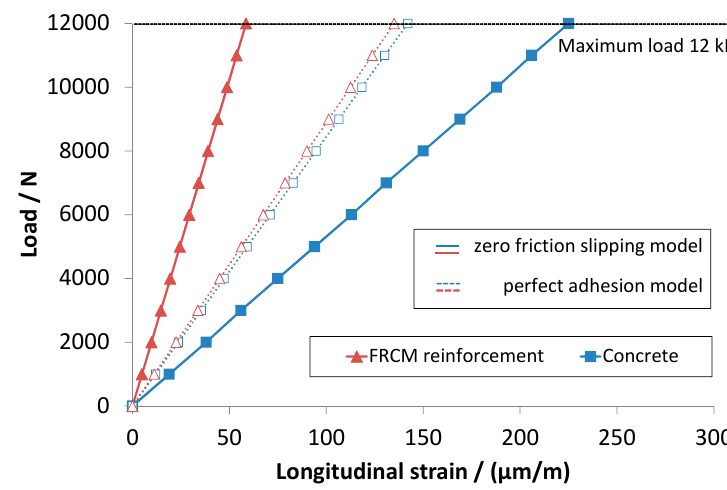
Figure 8. Load-strain curves obtained by applying Equations (18) (concrete) and (19) (Fiber Reinforced Cementitious Matrix) with data reported in Table 1.